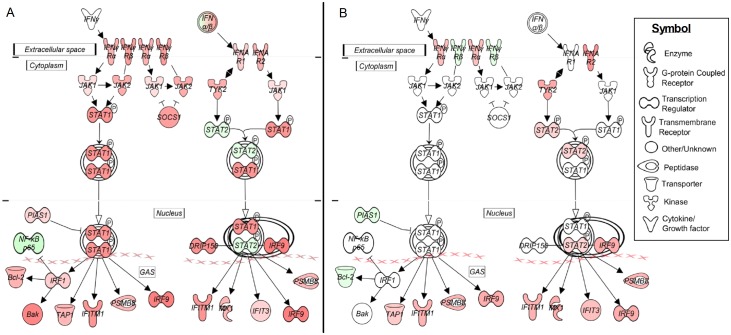
Differential regulation of interferon signaling pathway in the cavitary granulomas with different bacterial loads.Expression pattern and interaction of SDEG involved in canonical IFN signaling pathway in the cavitary granulomas with numerous (A) or scanty (B) AFB. For both (A) and (B), the up-regulated SDEG are in red and down-regulated SDEG are in green and the intensity of the color is proportional to their expression level (i.e., stronger expression is represented as dark shades).